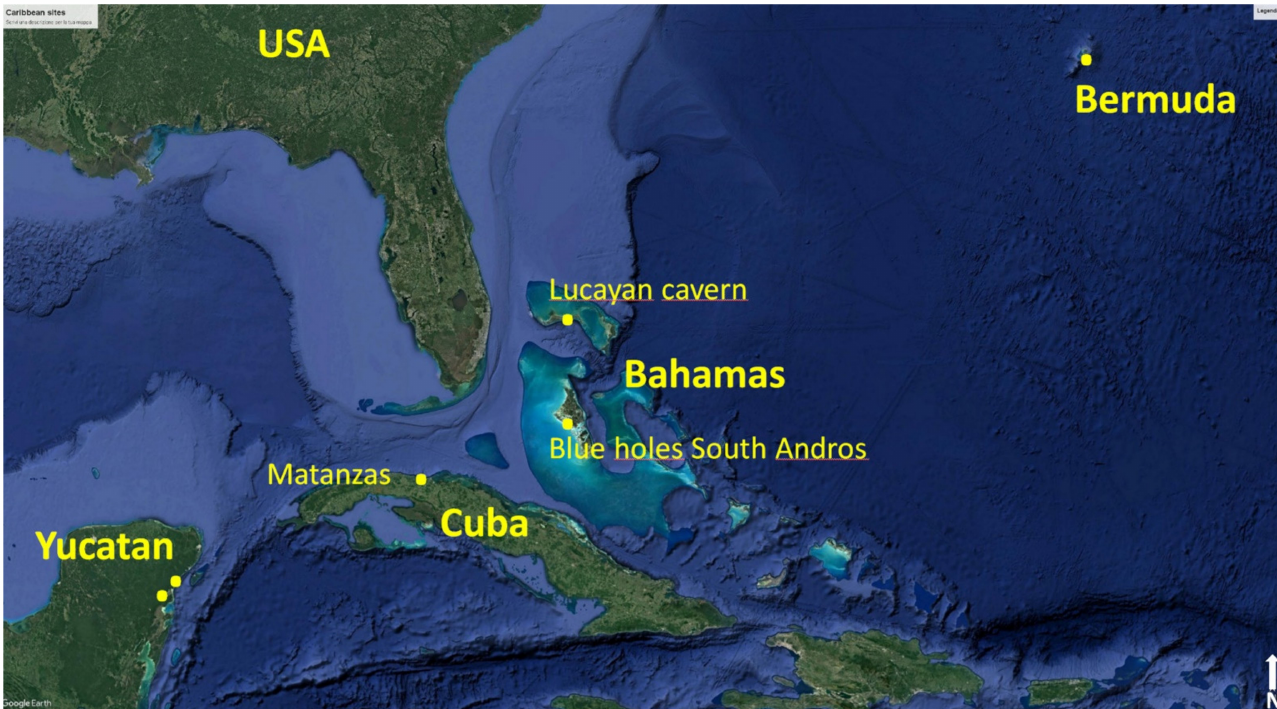
Figure 2. Overview of the Caribbean region showing the locations of the submerged caves or cenotes discussed in this study. Specific information (latitude, longitude, sampling depths, dating method, ages) is reported in Table 1.